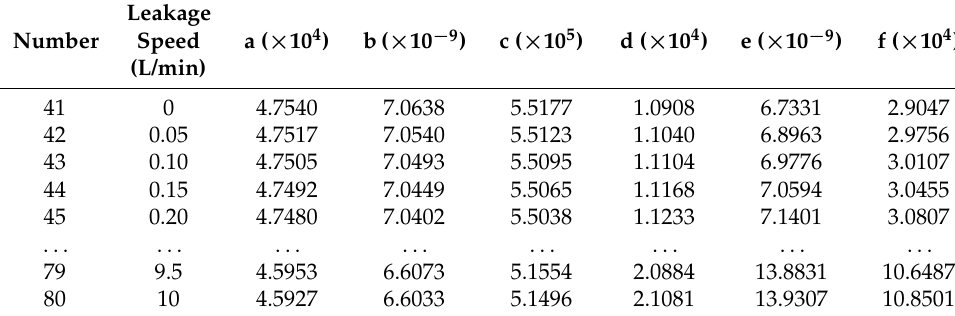
Table 11. Partial data of hydraulic cylinder leakage training set.